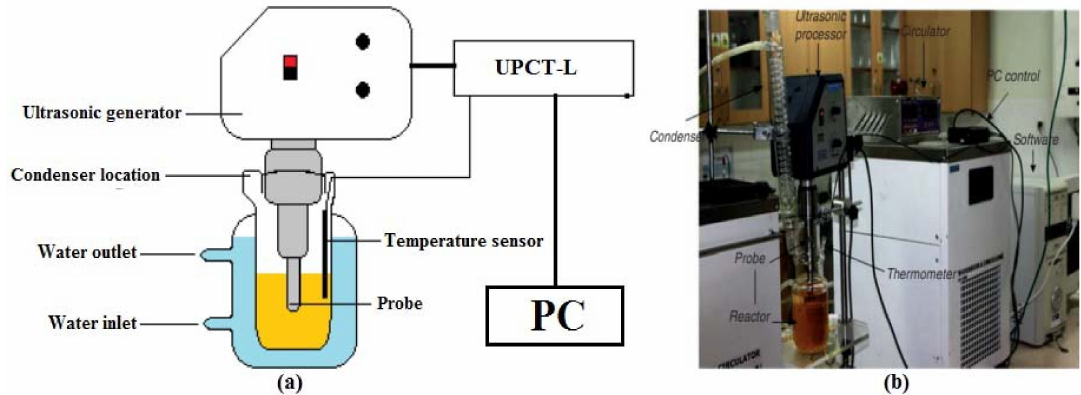
Figure 1. Ultrasonic-assisted biodiesel production process: ( a ) schematic, ( b )